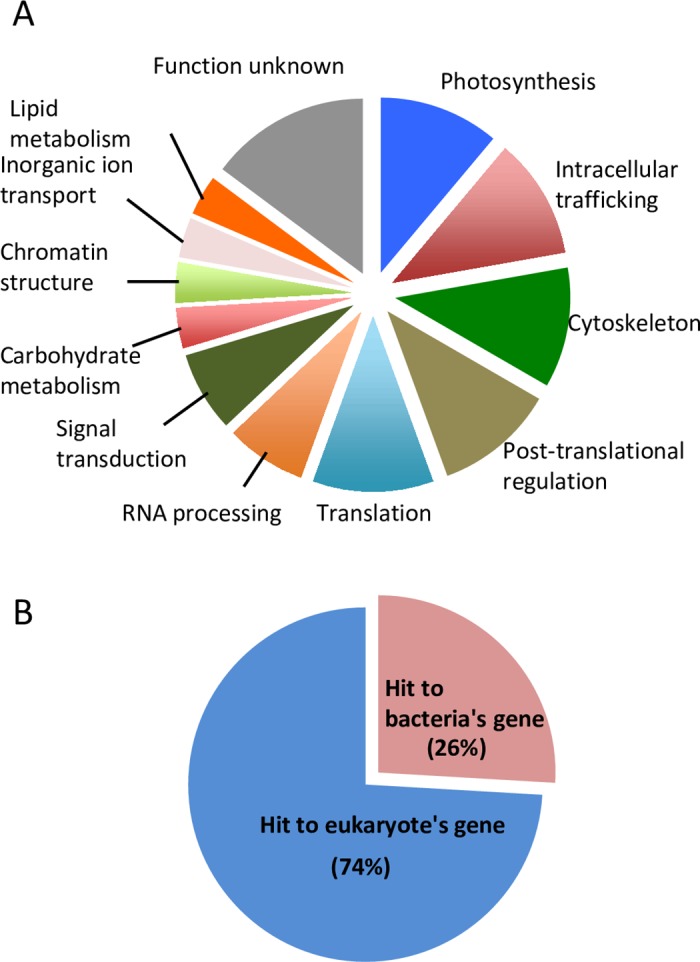
Functional and taxonomical classification of SL trans-spliced genes.A. Functional categorization of 27 trans-spliced genes of P. micropora according to COG and KOG classification [44, 45] with manual editing; a class of photosynthesis related function is added. B. Taxonomical classification of 27 SL trans-spliced genes based on the BLASTX annotation of the NCBI-nr database.